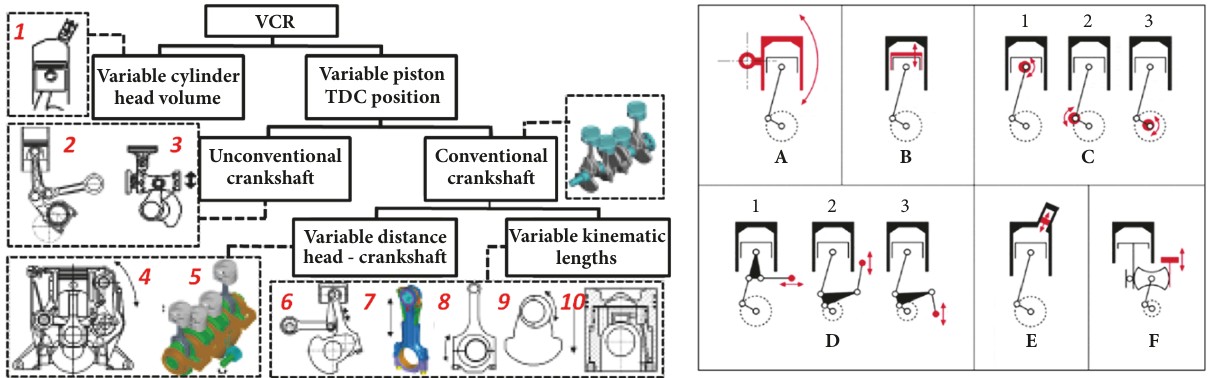
Figure 1: Classificationof thevarious VCR mechanisms (anevaluationmatrix). (a)VCR mechanismthatadjust theclearancevolumewithout modifying the (TDC) position: (1; E)–secondary piston for adjust the clearance volume; (4; A)–cylinder moves up by rotation; (10)–cylinder moves up by translation; (b) VCR mechanism that adjust the clearance volume by modifying the (TDC) position: (2, 6, 7; D)–linkage; adjust base pivot or link length; (3; F)–rocking, movement on one side generates opposite movement in piston; (B)–elastic components compress at higherpressures thus reducing clearance volume and reducing compression ratio at higher loads; (8, 9; C)–eccentric pivots; effectively adjusts link